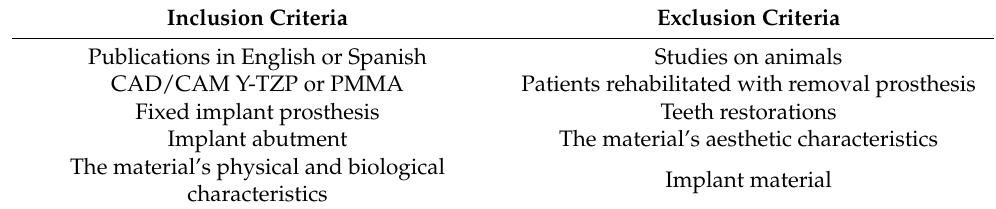
Table 3. Inclusion and exclusion criteria list.